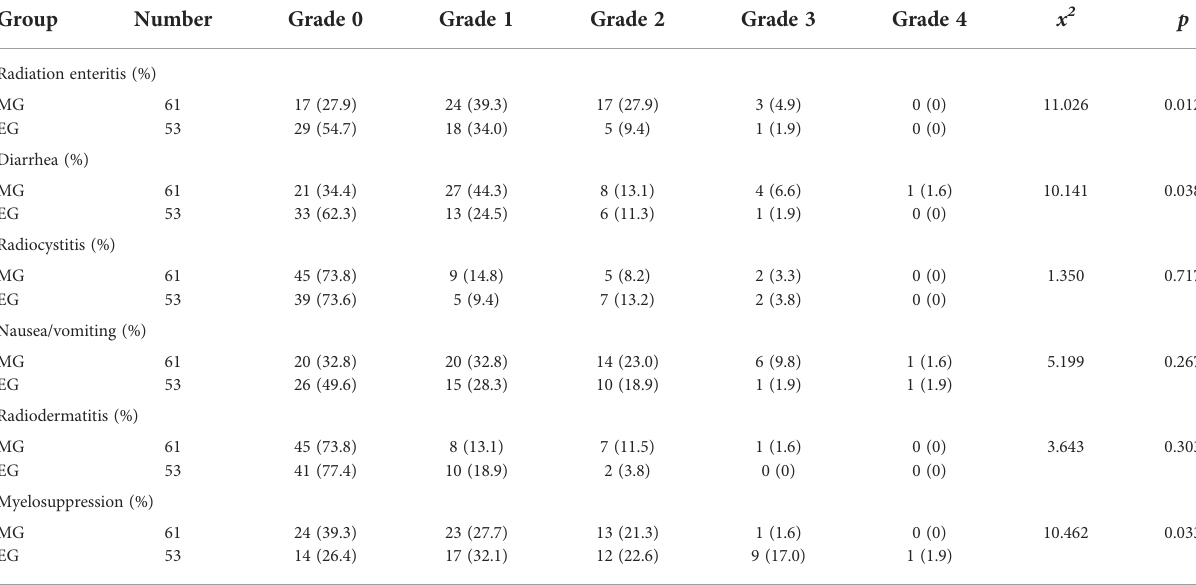
TABLE 5 Radiotherapy